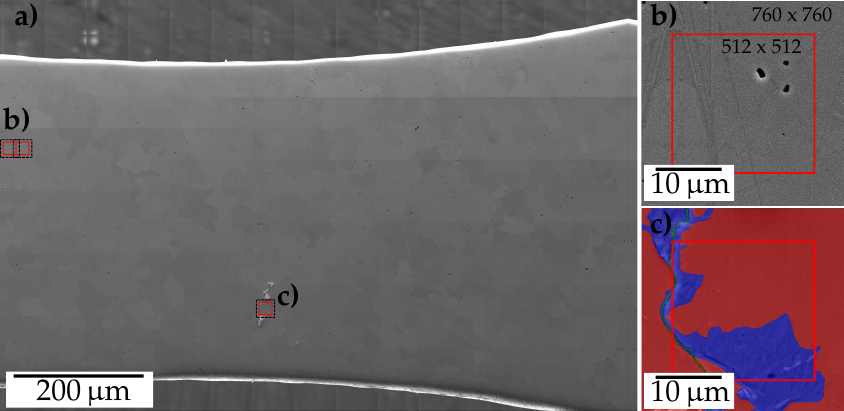
Figure 1. Overview stitched high-resolution secondary electron SEM image of a ferritic sample surface in ( a ). ( b ) Sample tile at the boundary indicating the original tile size and reduced labeling mask size retrieved from the network. The mirror padding applied at the boundary becomes apparent as well. ( c ) A tile at a short crack surrounded by extruded volume overlaid with the corresponding labeling mask displayed as a one-hot encoded RGB color image.